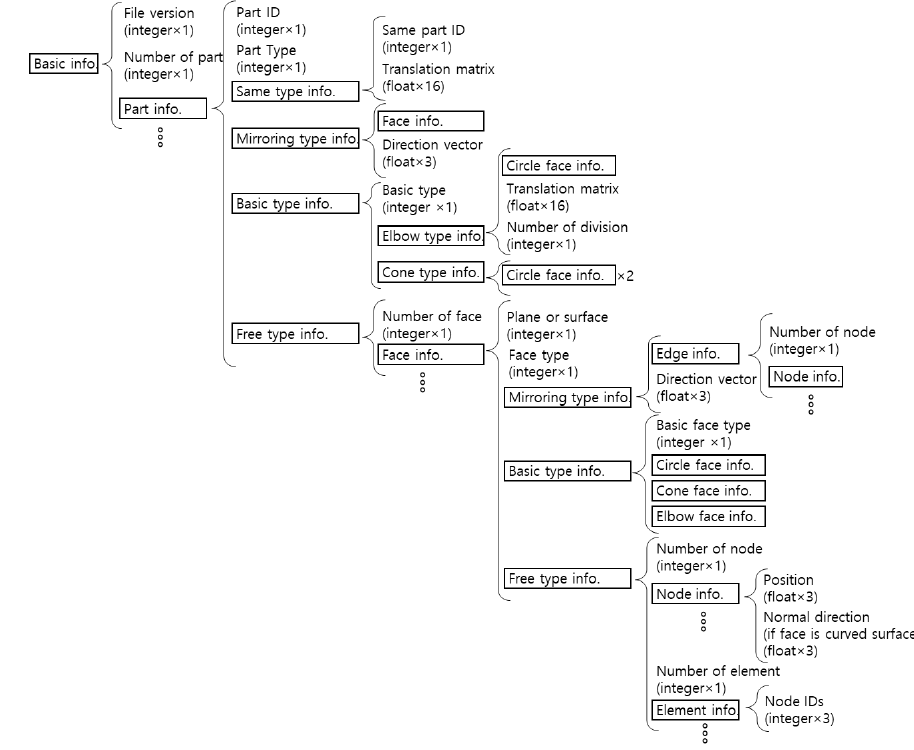
Figure 15. Proposed lightweight model file format.